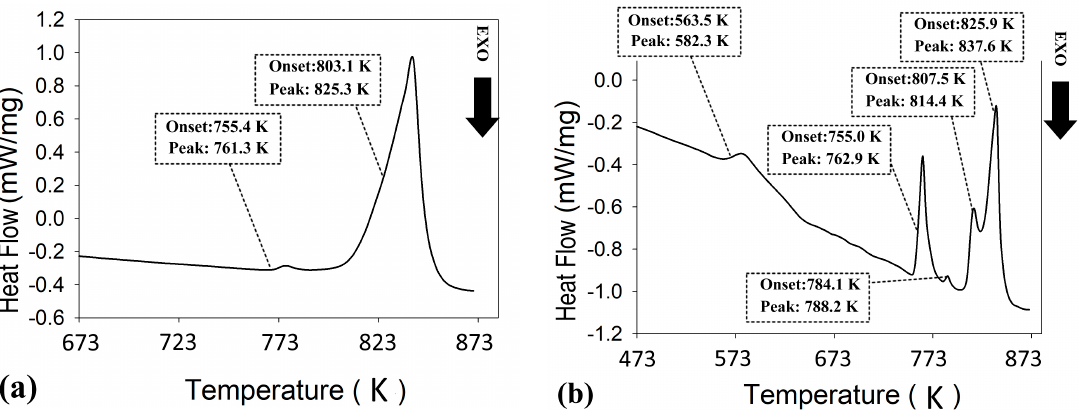
Figure 9. Differential scanning calorimetry (DSC) analysis of extruded ( a ) ZnSb, and ( b ) Zn 13 Sb 10 materials .